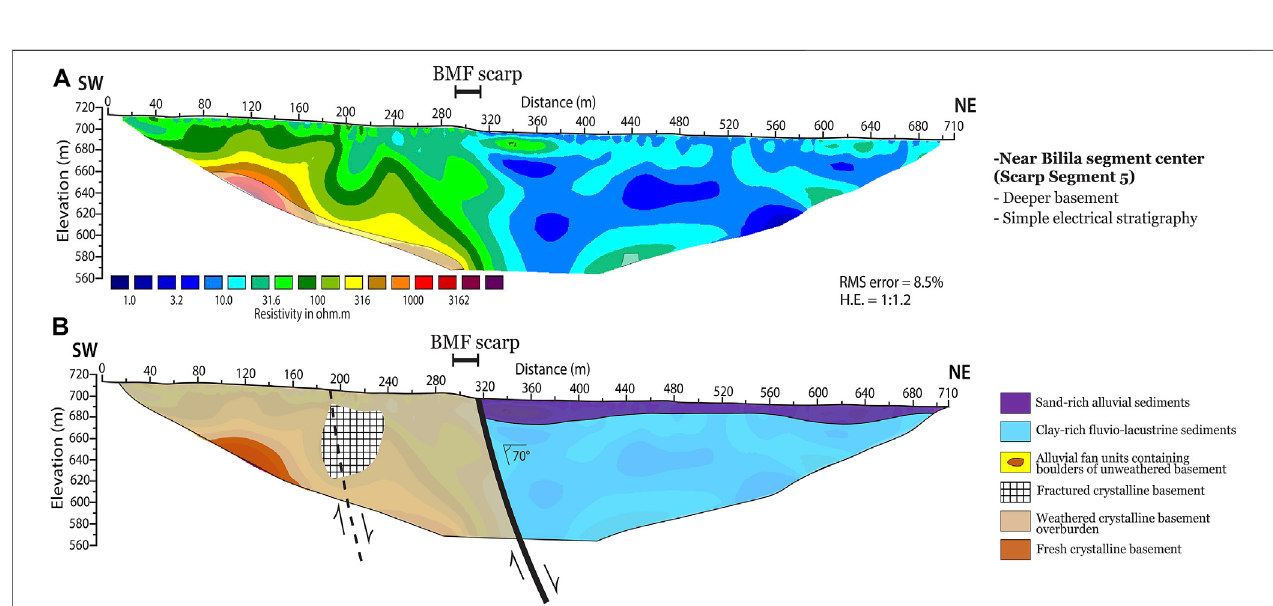
FIGURE10|(A) InversemodeloftheERTPro fi le4,acquirednearthecenteroftheScarpSegment5(Bililageometricalsegment)inthesouthernmostsectionofthe BMF. The white transparent polygons are areas of low model sensitivity ( Supplementary Figure S2B ). (B) Geologic model and interpretation of the resistivity model.